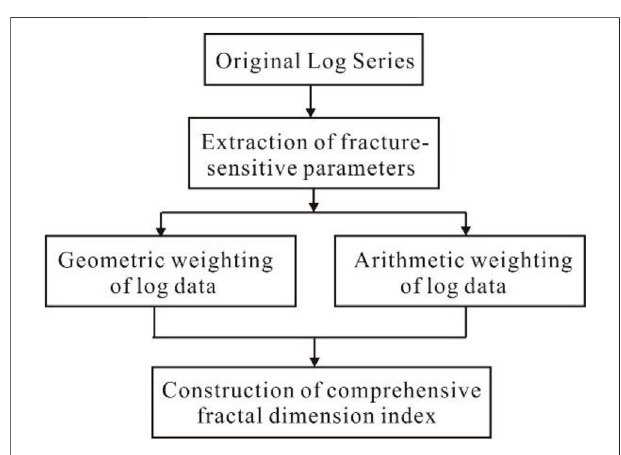
FIGURE 3 | Work fl ow of fracture identi fi cation model based on coupling of multiple conventional logging